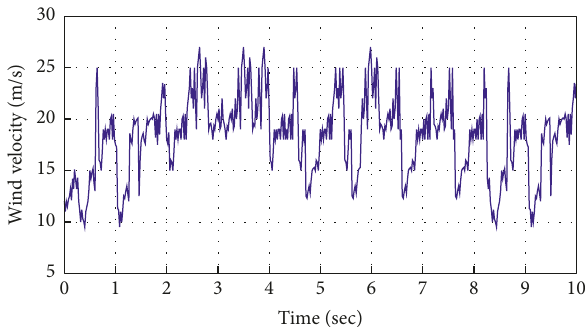
Figure 3: Time-varying reference wind velocity.